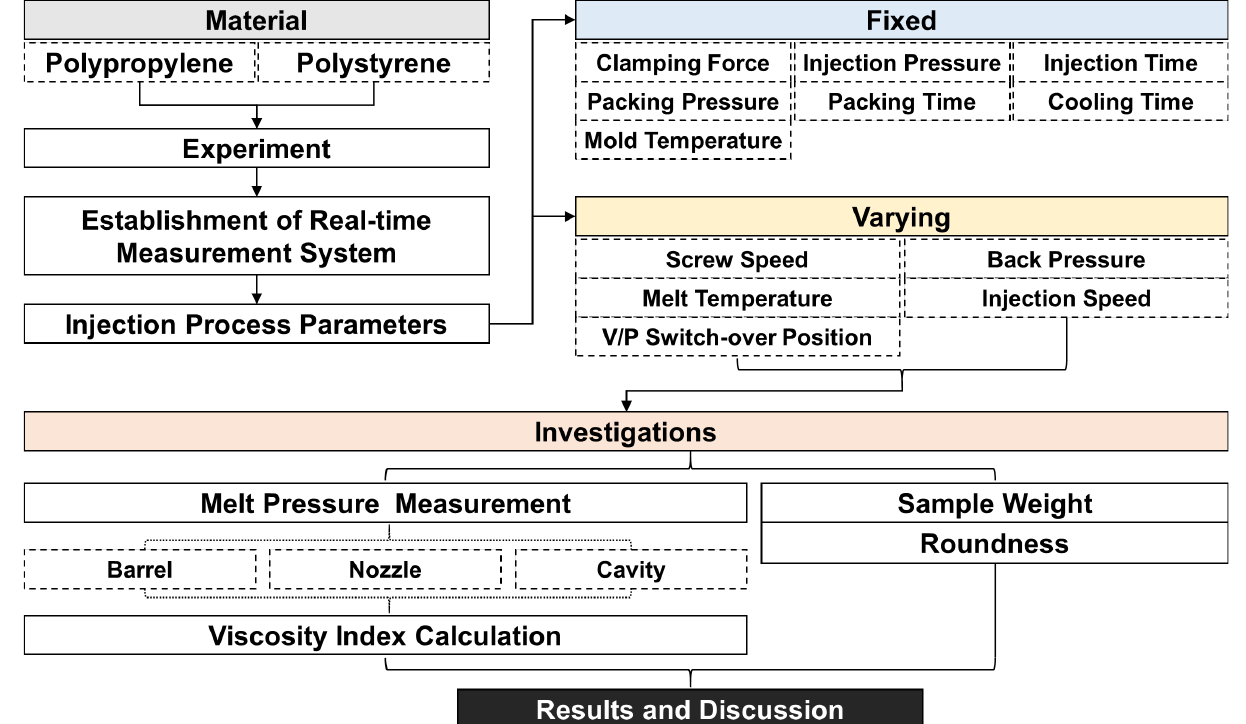
Figure 6. Flowchart of the DOE.